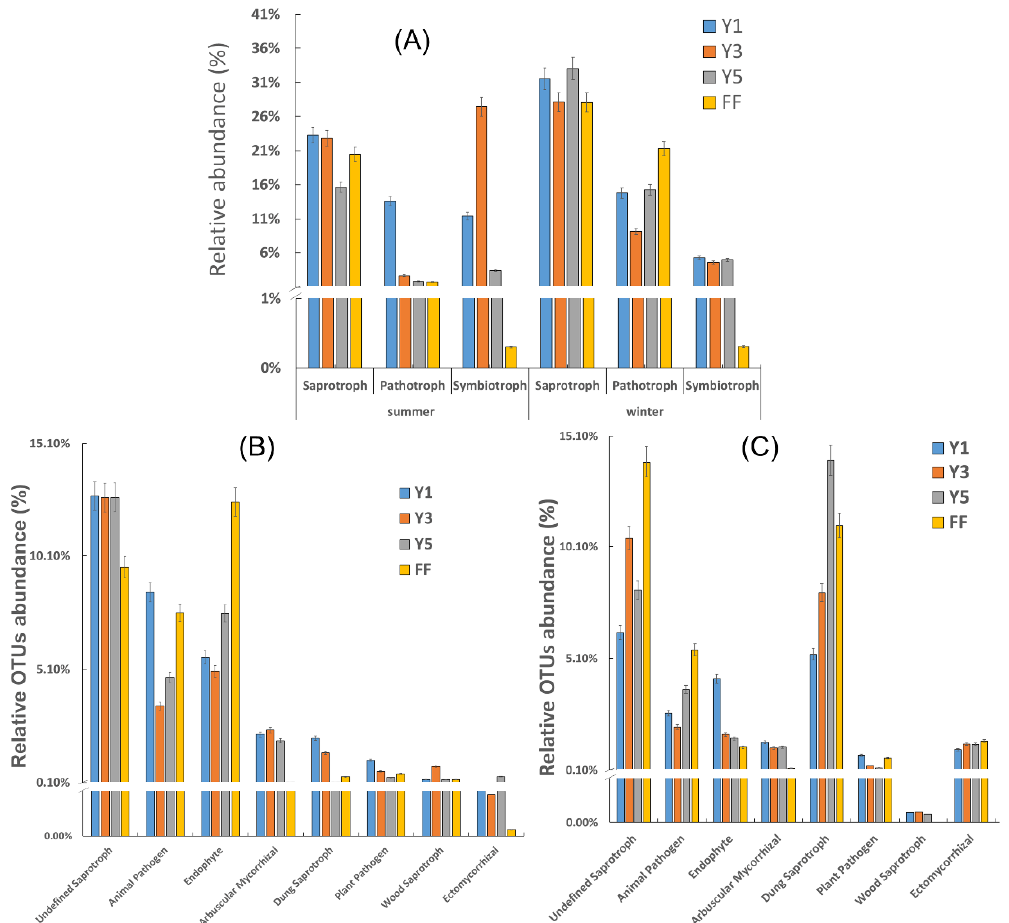
Figure 6. The relative abundance of three trophic modes in rhizosphere soil ( A ) relative abundance functional guild winter ( B ) and summer ( C ); FF: fallow field soil; Y1: one-year C. chinensis cultivated soil; Y3: three-year C. chinensis cultivated soil; Y5: five-year C. chinensis cultivated soil.